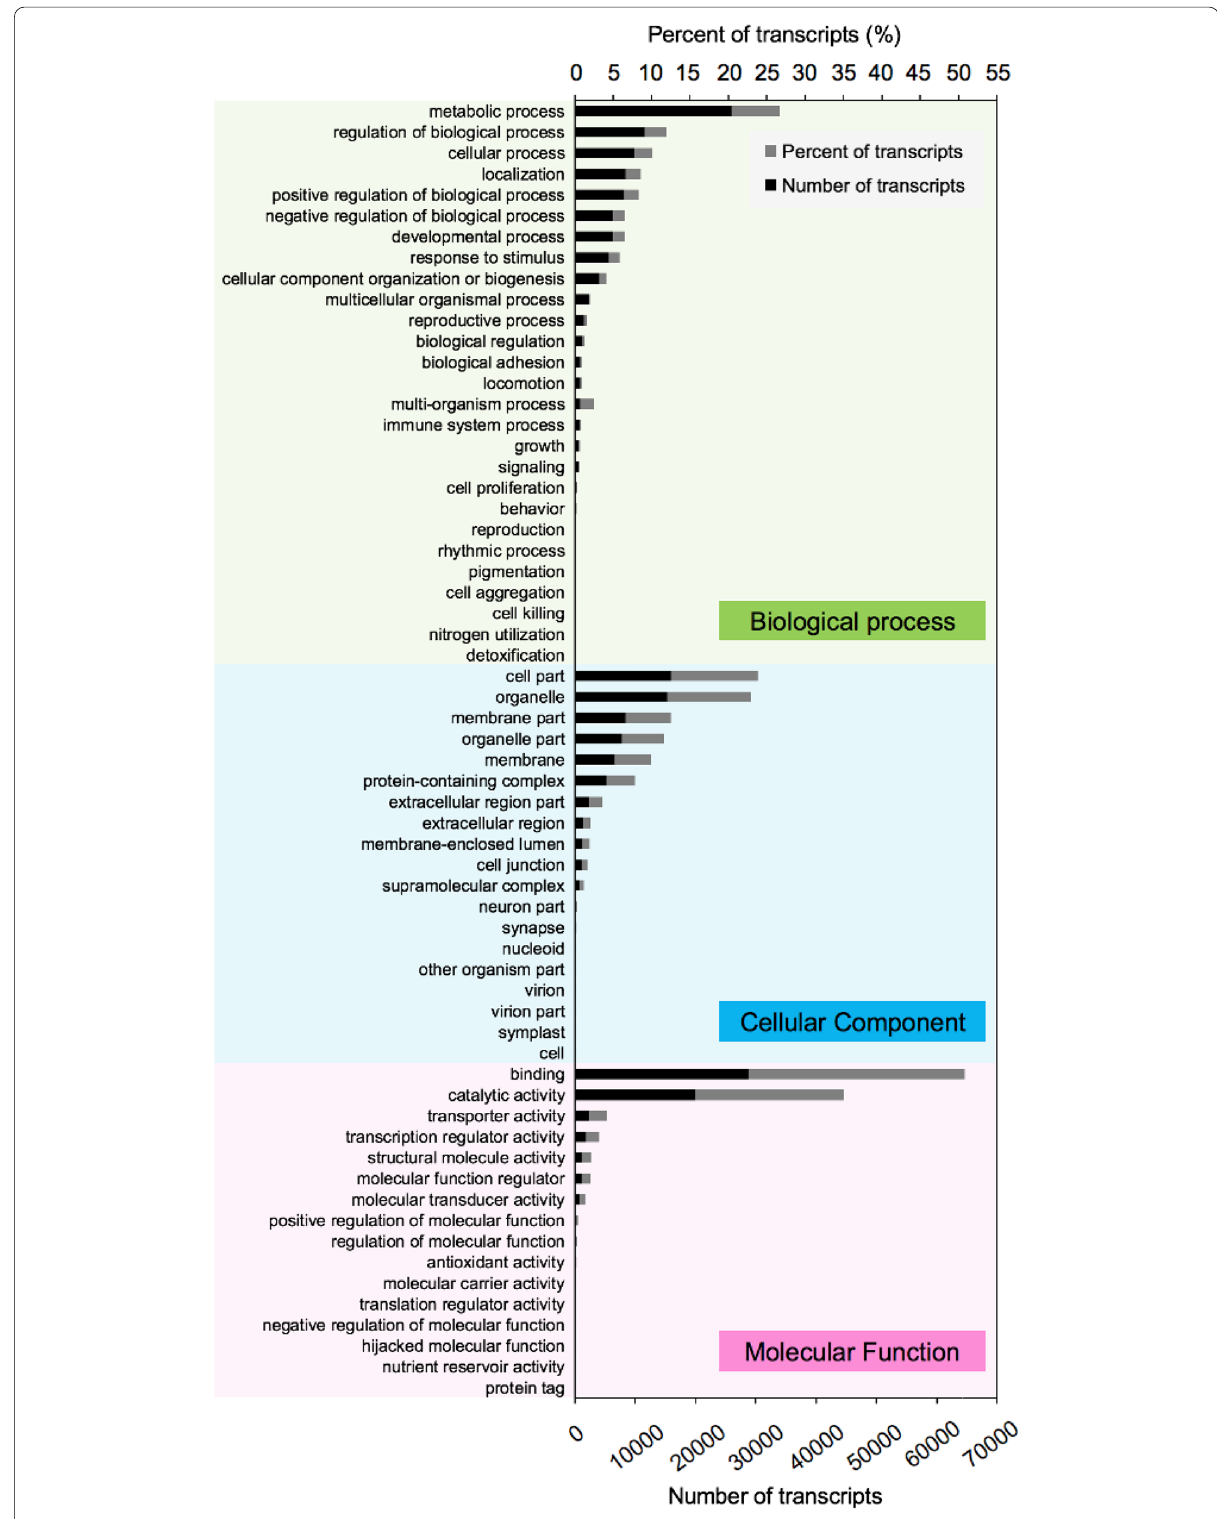
Fig. 2 Gene Ontology (GO) functional classification or categorization of S. mycoparasitica transcripts. Each annotated sequence or transcript was assigned to terms within the three major categories: biological process, cellular component, and molecular